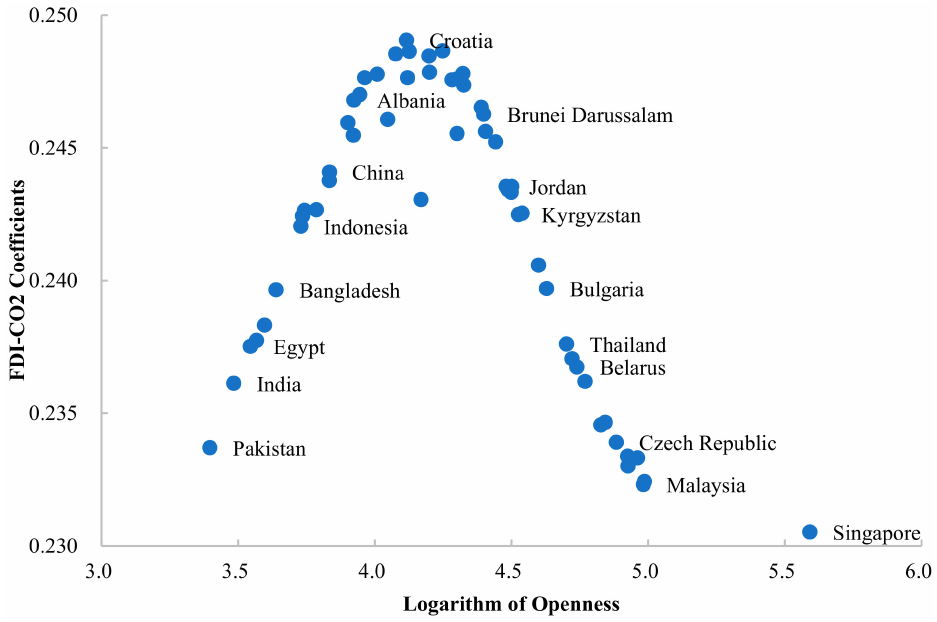
Figure 3. FDI-CO 2 coefficients of Belt and Road countries (openness